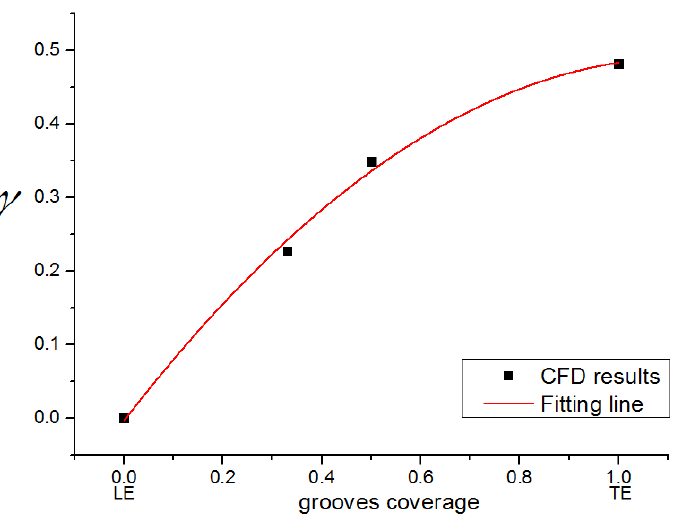
Figure 10. Stability enhancement effects of the different CT models.